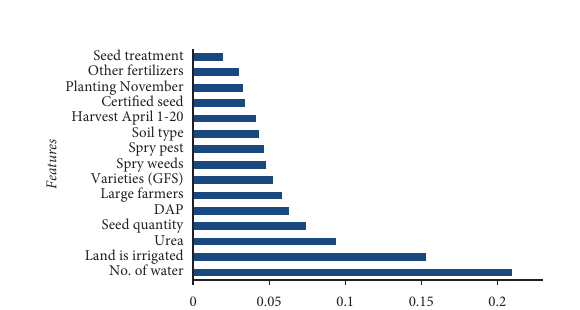
Figure 5: Feature importance for D2.